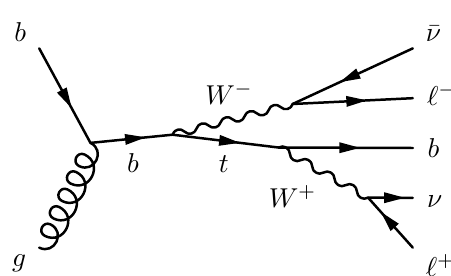
Figure 1. A representative leading-order Feynman diagram for the production of a single top quark in the Wt channel and the subsequent leptonic decay of both the W boson and top quark.